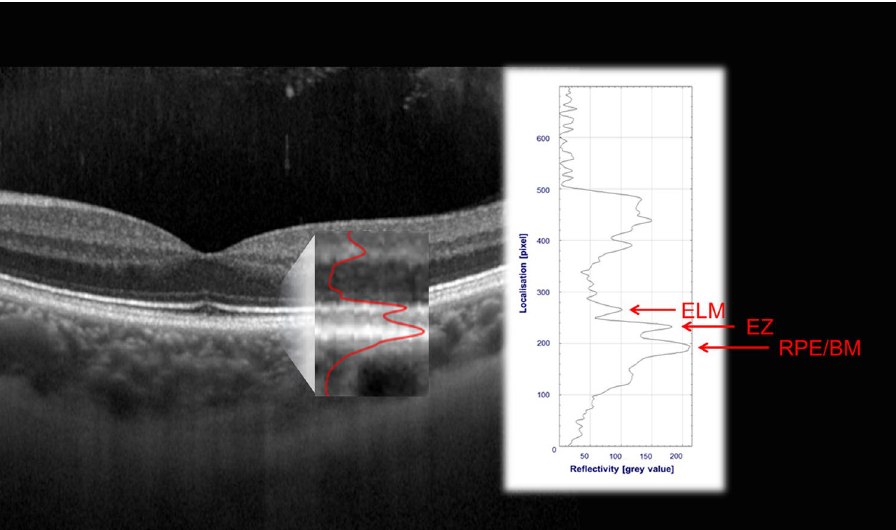
Figure 4. Quantification of SD-OCT based outer retina reflectivity in corresponding reflectivity profiles in a representative healthy case. Each hyperreflective outer retinal band (e.g., the external limiting membrane (ELM), the ellipsoid zone (EZ) or retinal pigment epithelial/Bruch’s membrane complex (RPE/BM)) specifically corresponds to a peak in the reflectivity profile (see red overlay on SD-OCT image detail). Peak detection and assessment of the peak height in the reflectivity profile allows for reflectivity